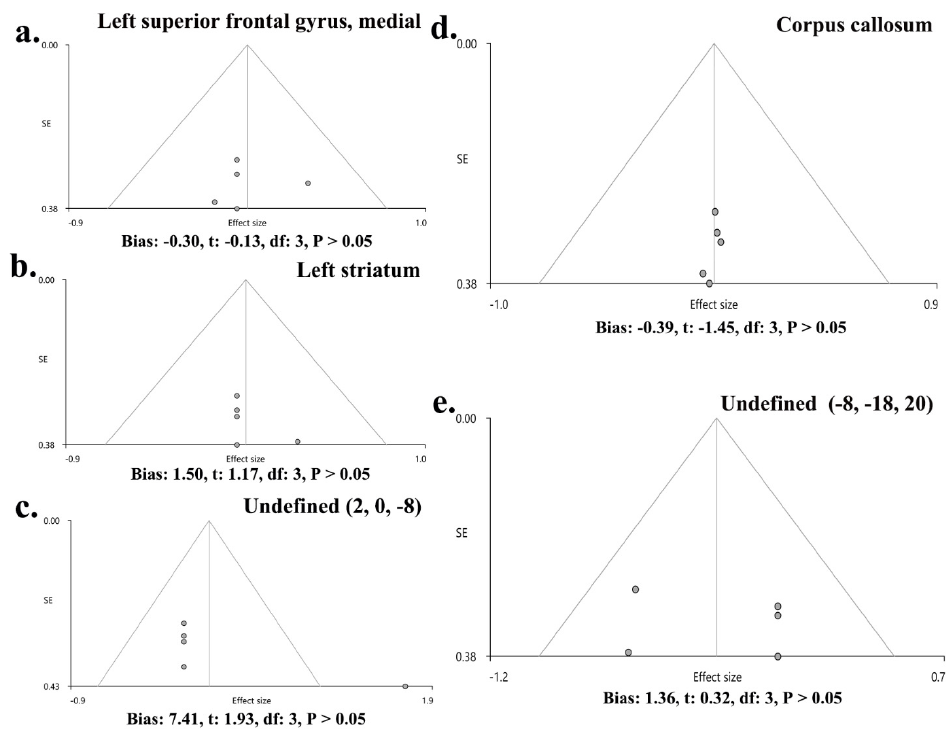
Figure 4. Funnel plots of publication bias in the main results. The main results showed no publication bias in SFGmedial (bias: − 0.30, t: − 0.13, df: 3, p > 0.05) ( a ), left striatum (bias: 1.50, t: 1.17, df: 3, p > 0.05) ( b ), undefined area (2, 0, − 8) (bias: 7.41, t: 1.93, df: 3, p > 0.05) ( c ), CC (bias: − 0.39, t: − 1.45, df: 3, p > 0.05) ( d ), and undefined area ( − 8, − 18, 20) (bias: 1.36, t: 0.32, df: 3, p > 0.05) ( e ).